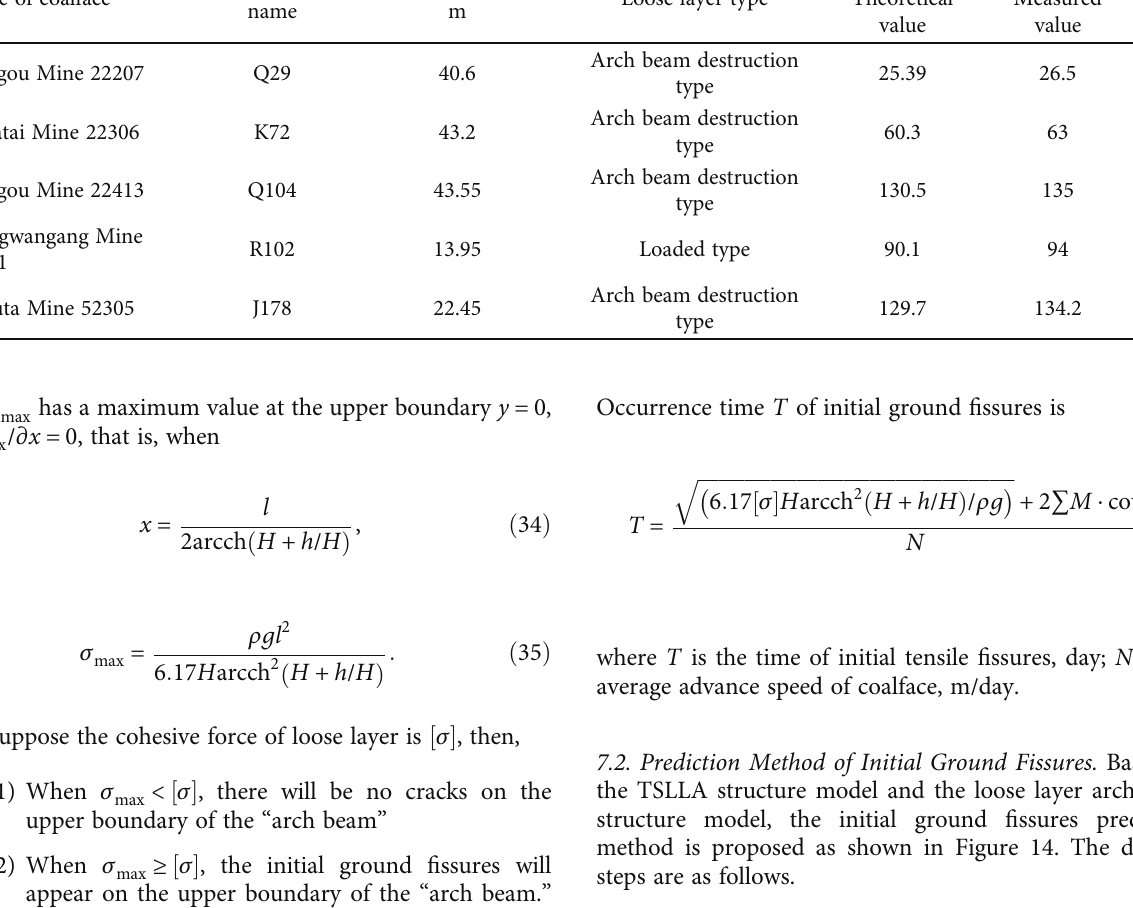
Table 3: Prediction of ground fi ssures in typical working faces in Shendong mining area. Name of